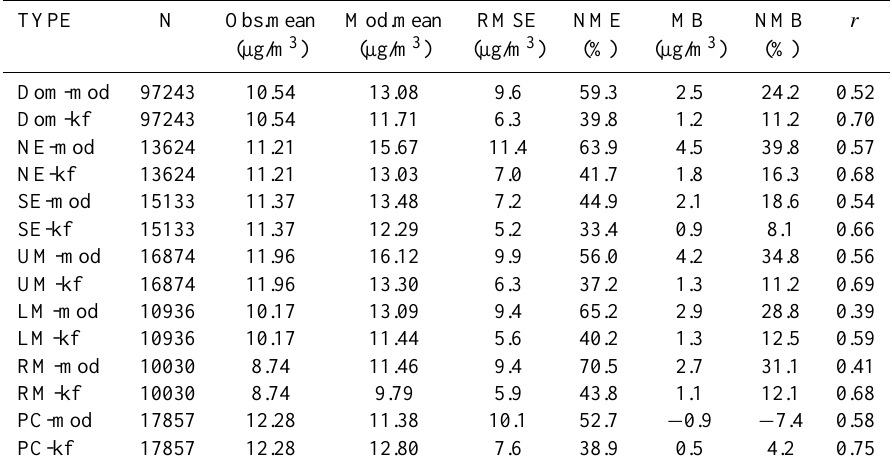
Table 1. Regional summary of discrete statistics for raw model and KF bias-adjusted daily mean PM 2 . 5 forecasts during 2007 cool season ( n is the number of records).